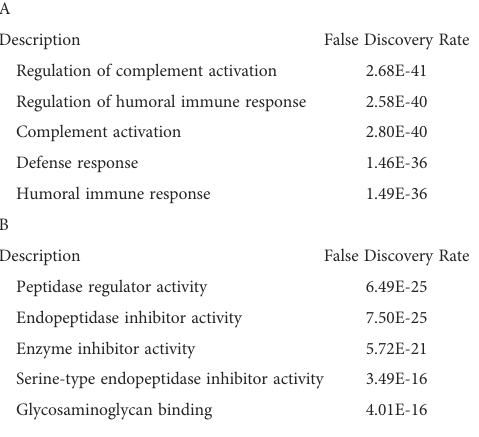
TABLE 2 Proteomic Pathways in